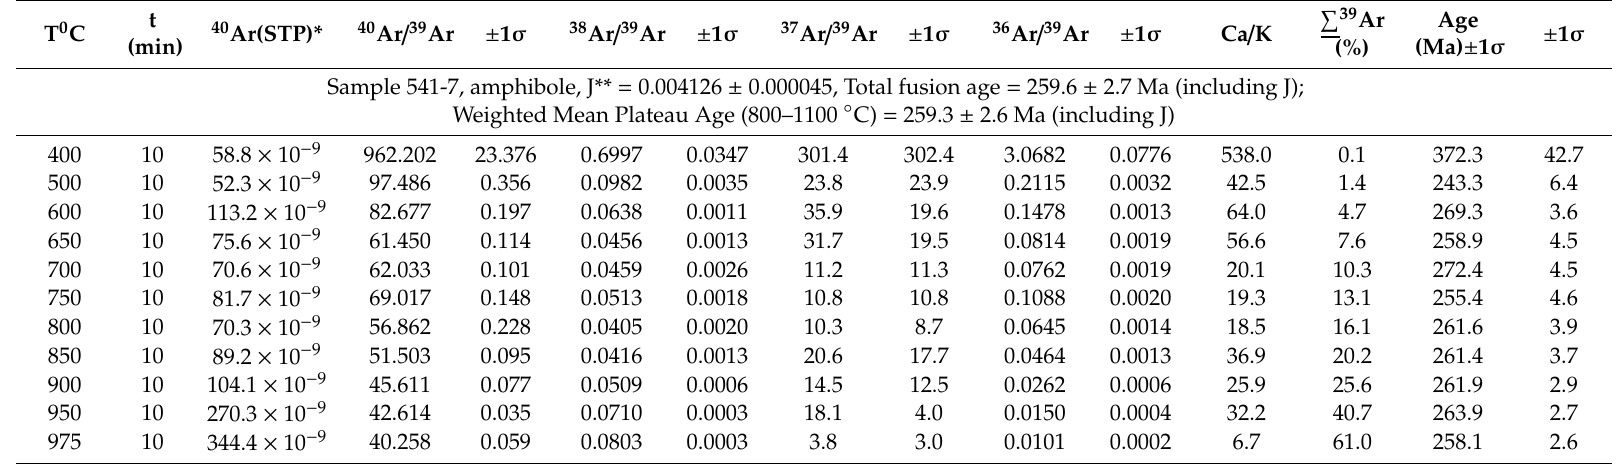
Table A4. Results of 40 Ar / 39 Ar dating for samples 541-7 and